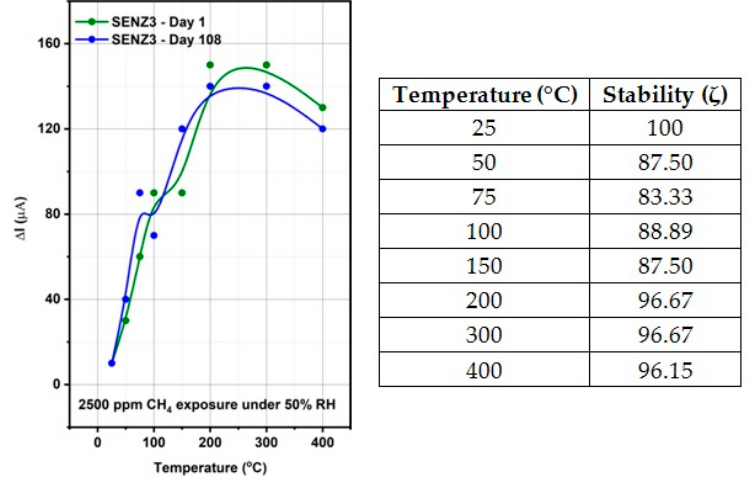
Figure 10. Stability of the conversion e ff ects with respect to the SENZ3 (7Ce3Mn / 10LaAl_imp) over 108